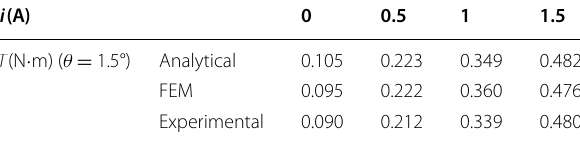
Table 4 Comparison of torque-angle characteristics